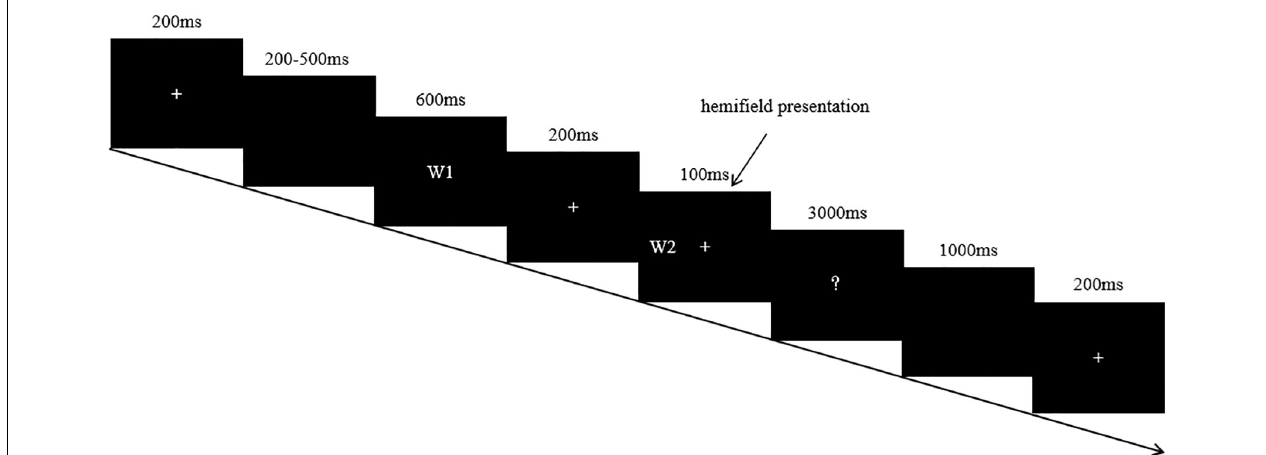
FIGURE 1 | Experimental paradigm. (W1 and W2 refer to word 1 and word 2